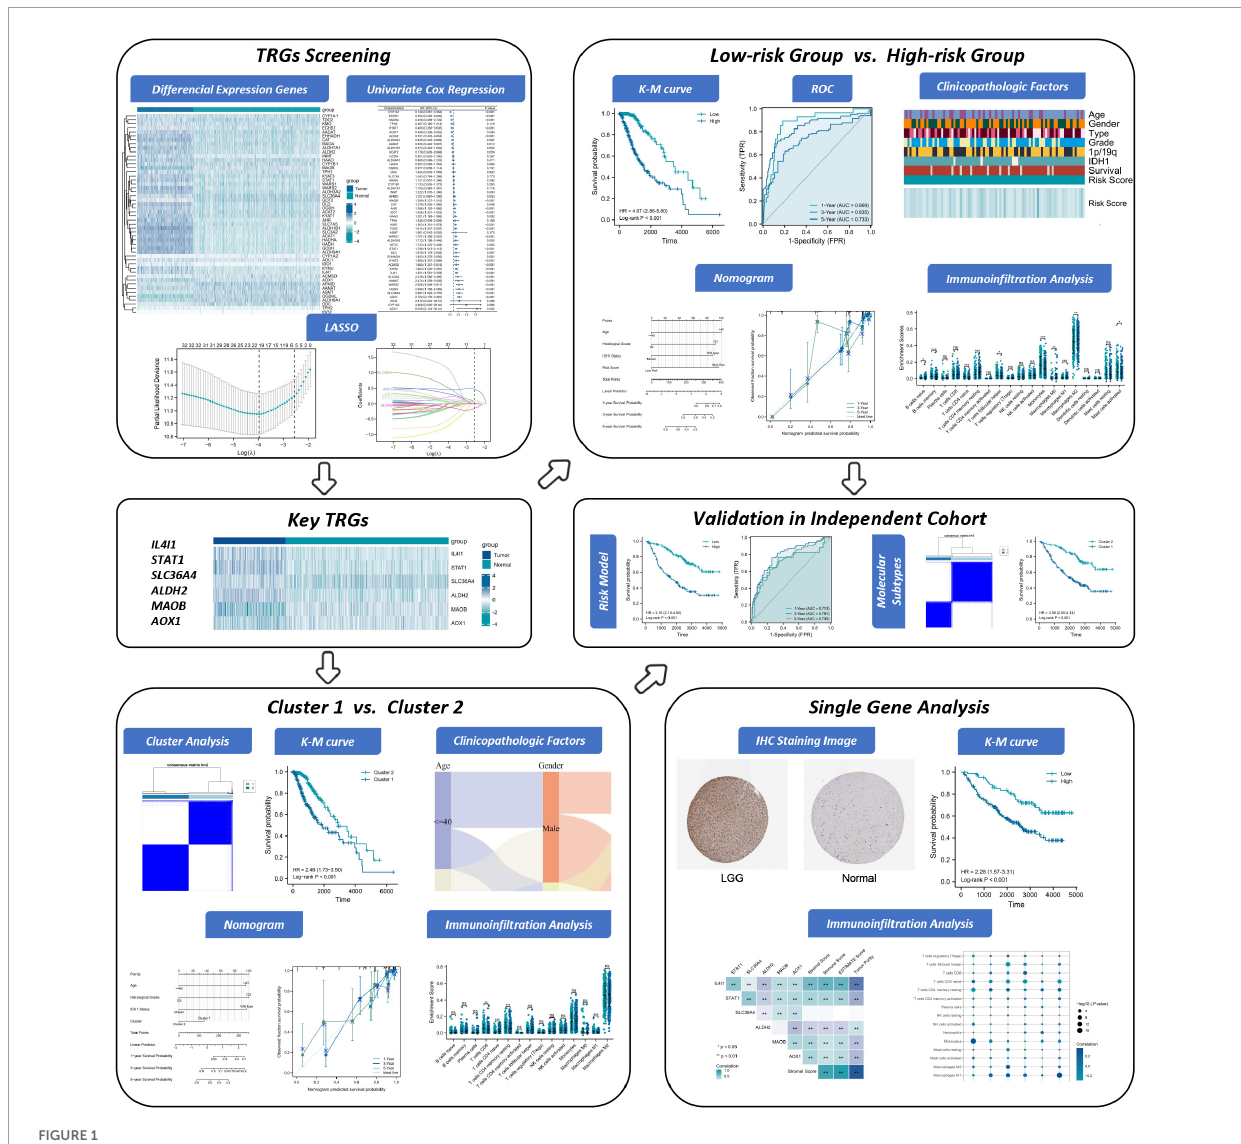
FIGURE1 The flowchart of this